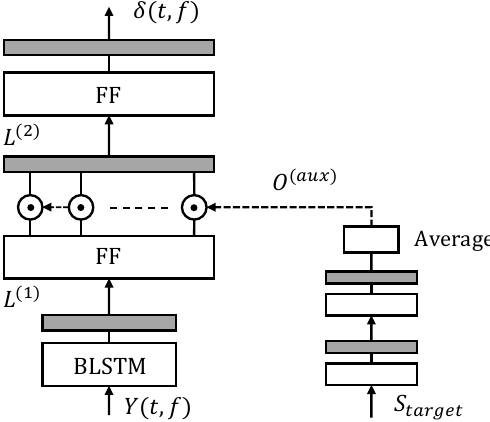
Figure 1. Architecture of the speaker-aware time-frequency selection neural network. The grey components represent non-linear activations, which are ReLU ( x ) = max ( 0, x ) for the feed-forward